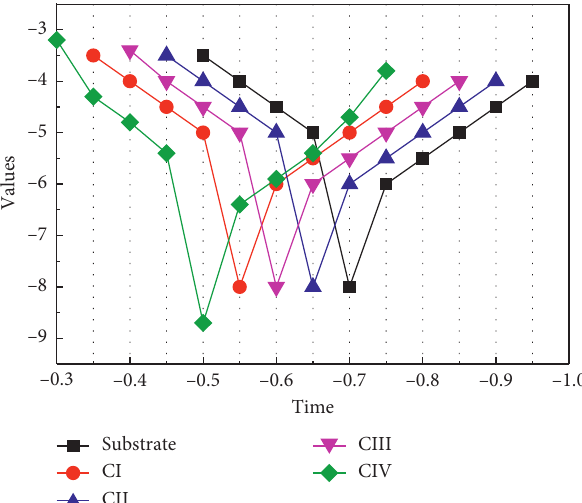
Figure 5: Diagram of the main errors in tracking.